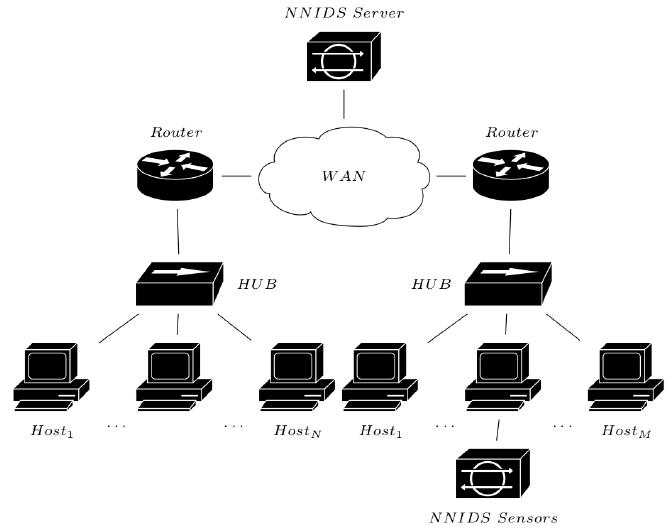
Figure 4. IDS network-node-based